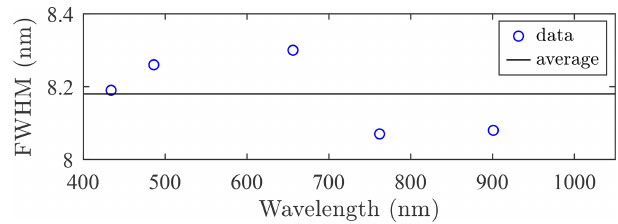
Figure 6. Bandwidth mismatch error for a star of spectral class A (Vega, HR7001). Open circles are the nominal starphotometer chan-